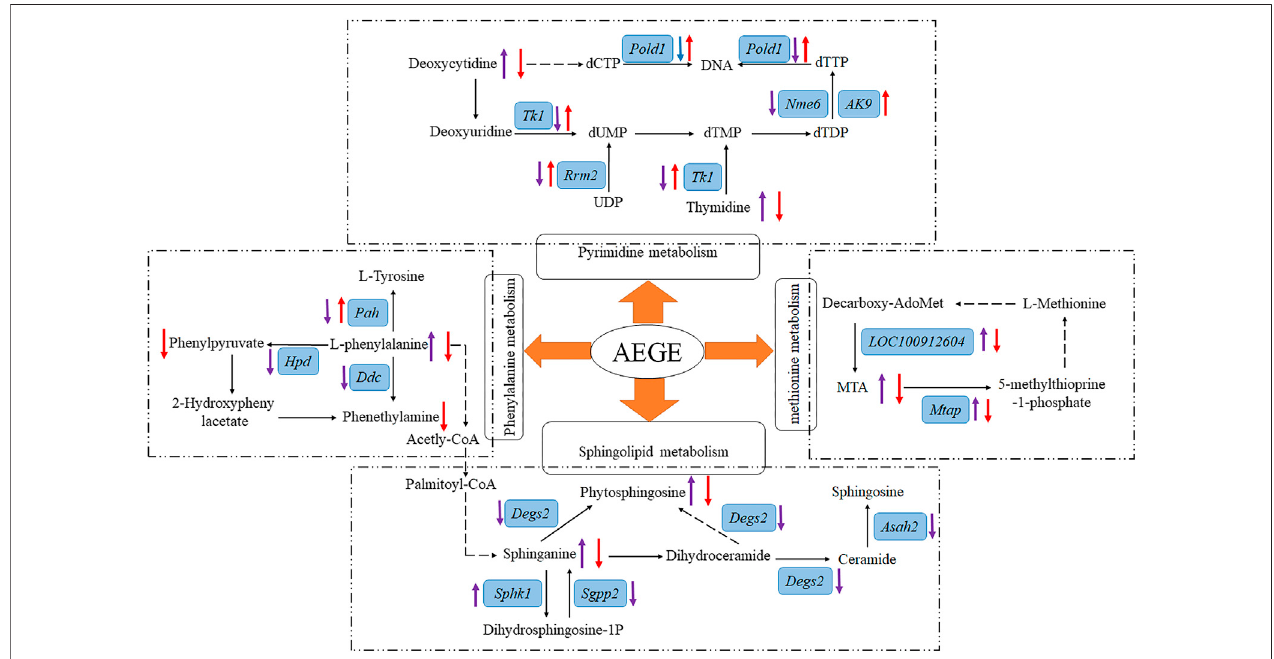
FIGURE 6 | Overview of metabolic pathway analysis. After treatment with AEGE, the concentration or expression of metabolites and genes (blue background and italic)werechanged( “ ↑ ” meansupregulated; “ ↓ ” meansdownregulated;purplearrowrepresentstheratioofIRtoshamgroups;redarrowrepresentstheratioofAEGEto IR groups). Dashed arrow indicates multiple steps in the